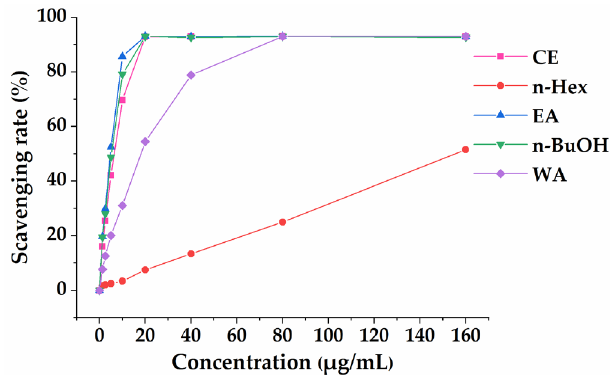
Figure 1. The scavenging rate (%) of ABTS by CE, n-Hex, EA, n-BuOH and WA fractions of A. indica . All of the values are expressed as means (%) ± SD of triplicated experiments.